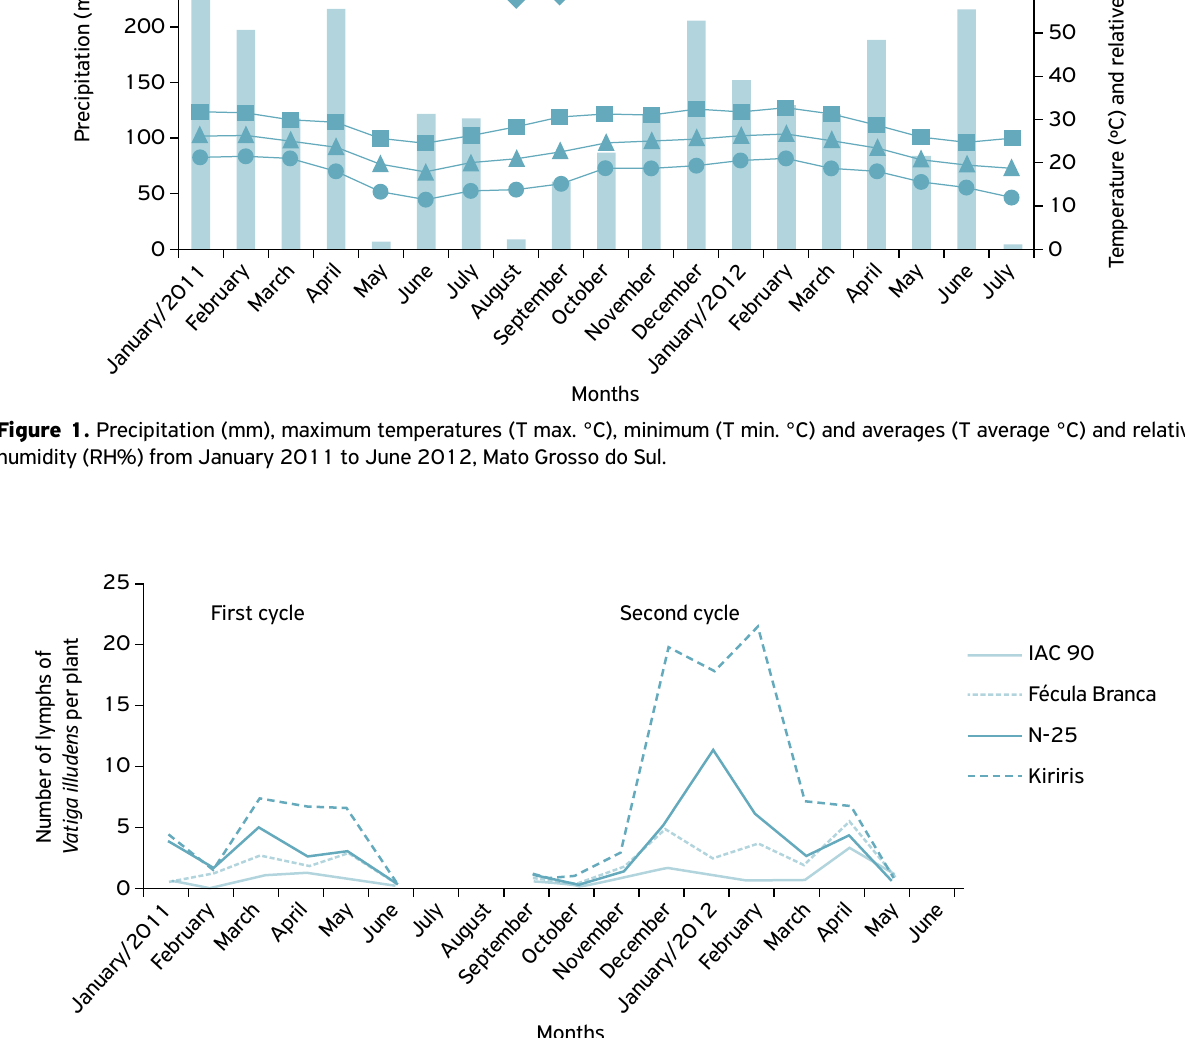
Figure 2. Mean population fluctuation of nymphs of Vatiga illudens (Hemiptera: Tingidae) in different cassava cultivars from January 2011 to June 2012, Dourados, Mato Grosso do